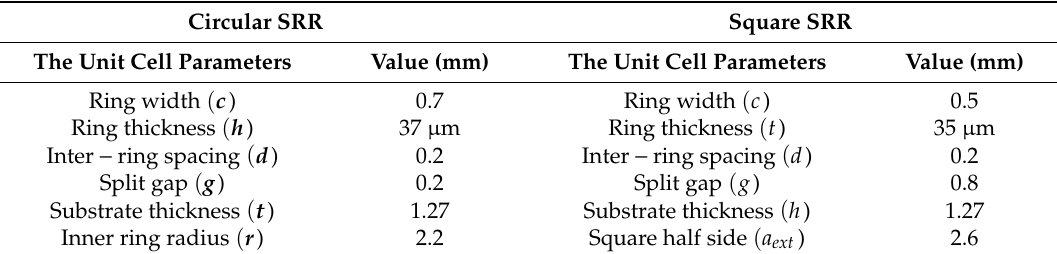
Table 3. Circular and square SRR unit cell parameters.